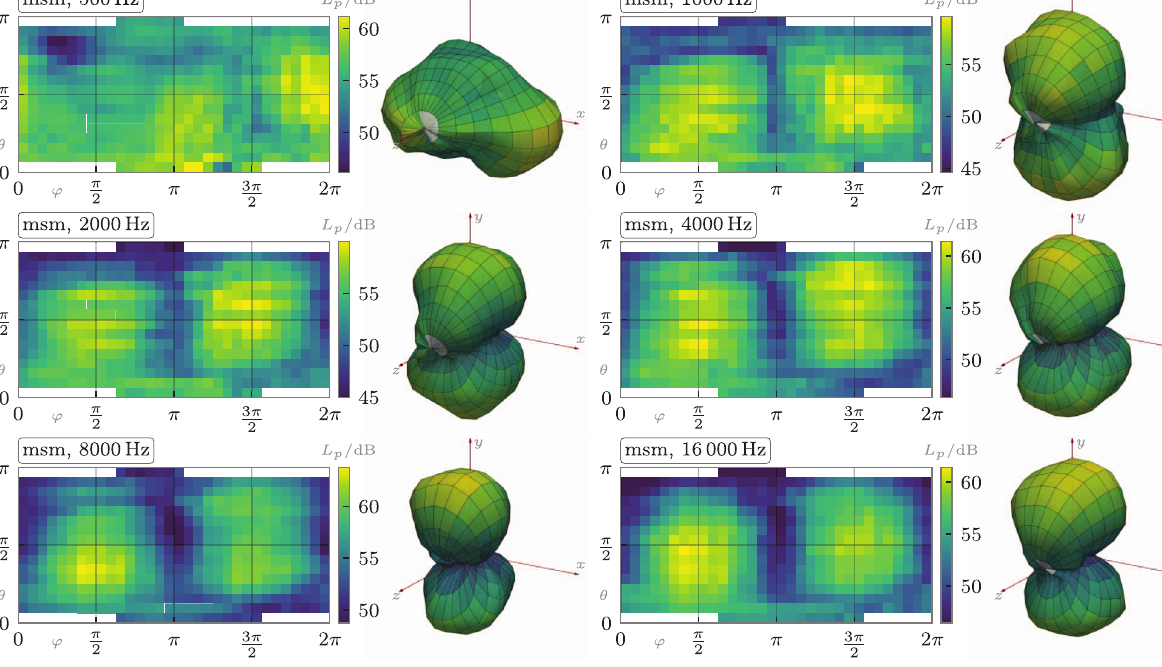
Figure 12. Measured drone: visualization of the directional sound radiation using the EA 512 grid, evaluated for six octave bands.